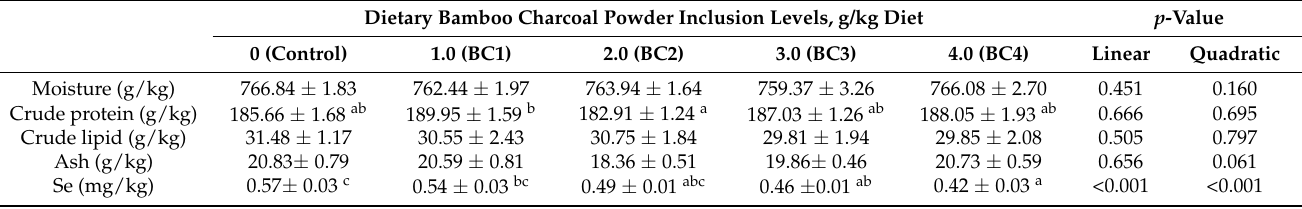
Table 4. Muscle composition in juvenile blunt snout bream fed with the experimental diets 1